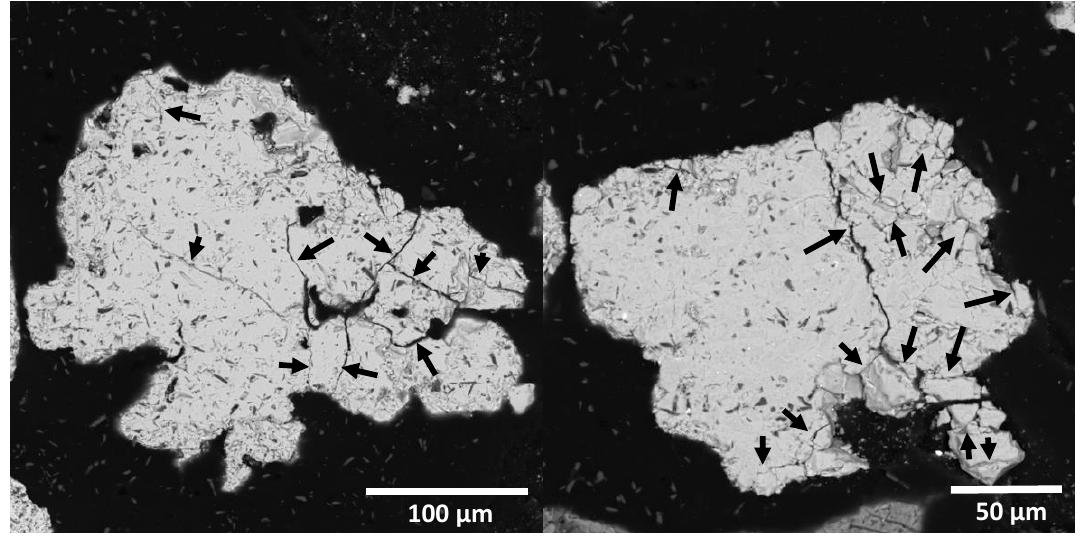
Figure 5. BSE images of partially leached samples (0 rpm and 2700 s) of converter slag for analysis (455 × and 656 × magnification). The arrows indicate the microcracks inside the structure.